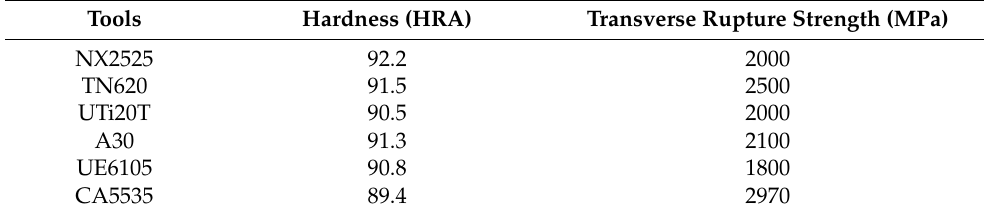
Table 2. Mechanical properties of tool materials.